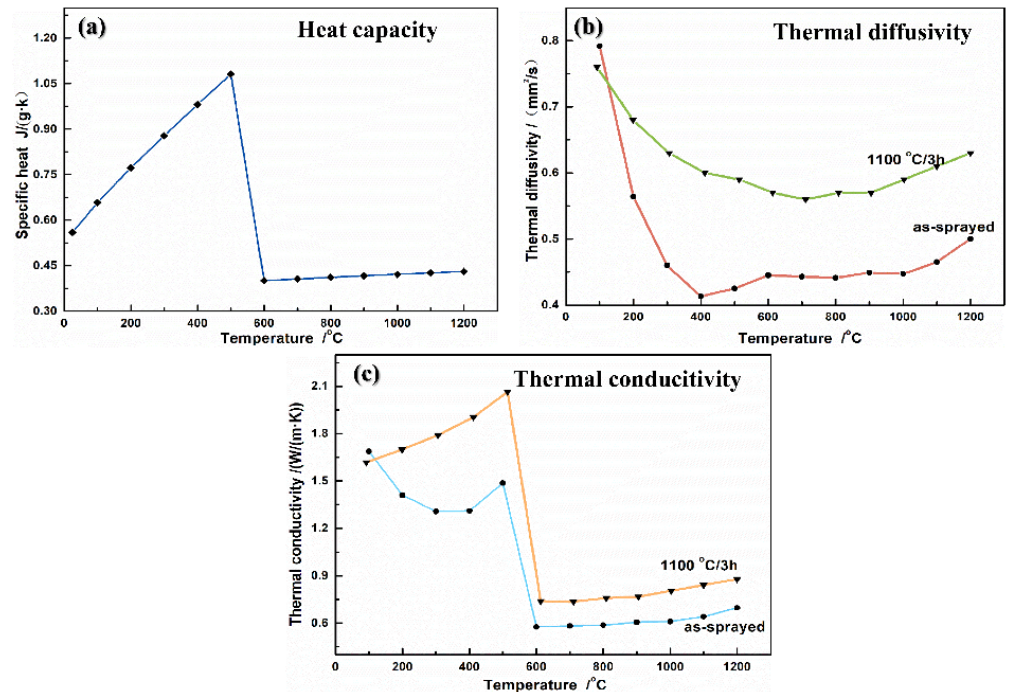
Figure 9. Heat capacity ( a ), thermal diffusivity ( b ) and thermal conductivity ( c ) of as-sprayed and 1100 °C/3 h aged CZSO coating.